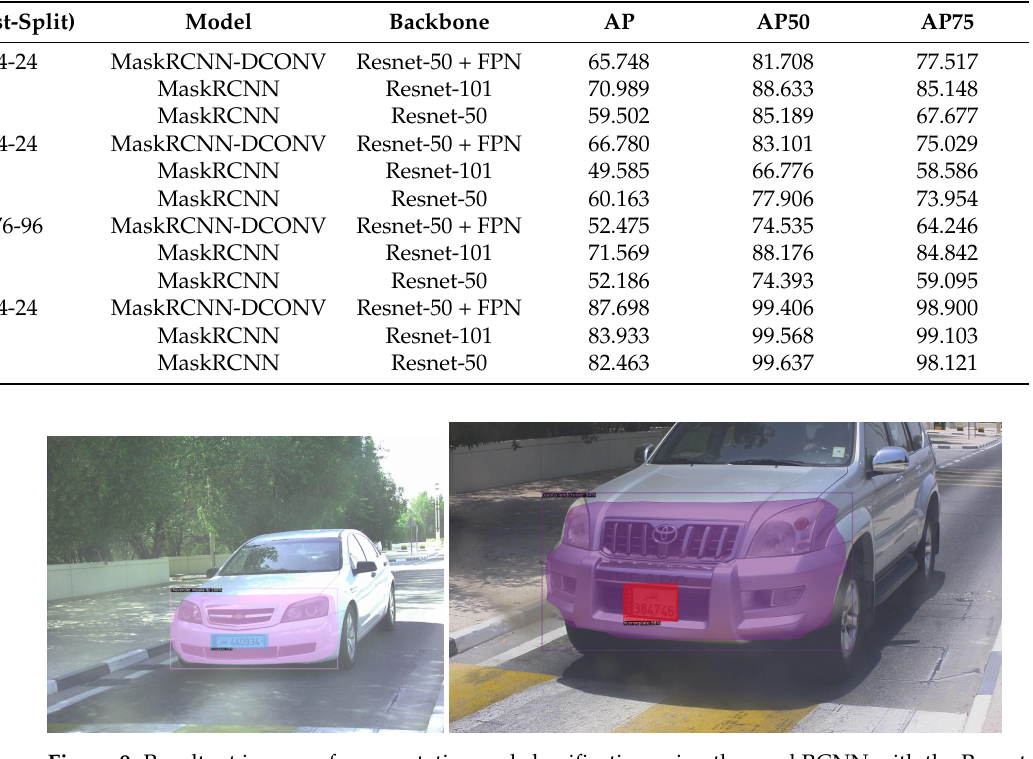
Figure 9. Resultant images of segmentation and classification using the maskRCNN with the Resnet- 50 backbone.